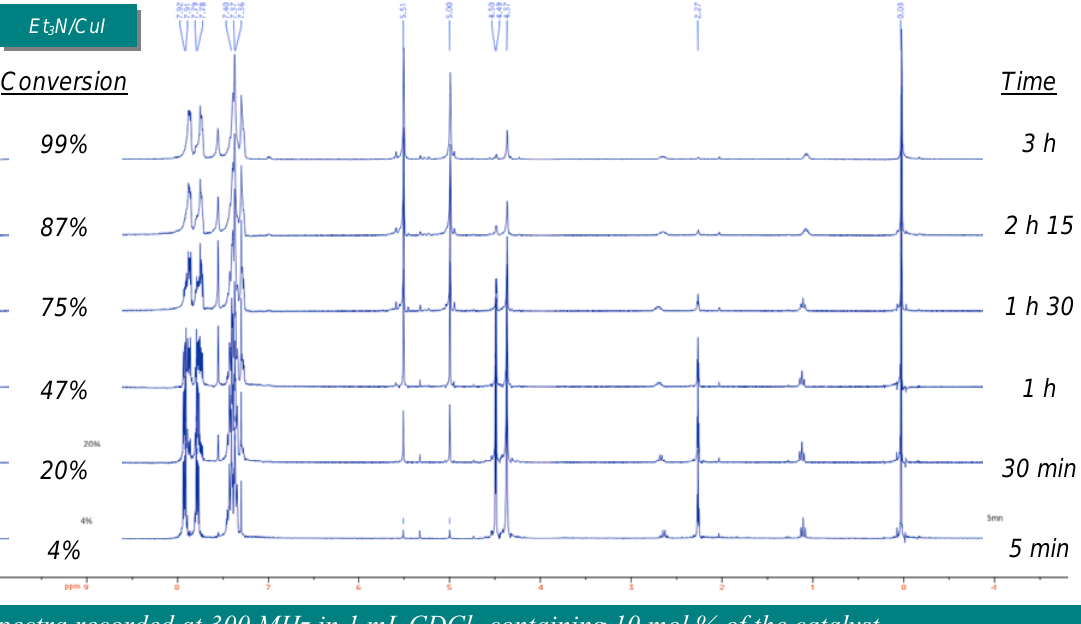
containing 10 mol % of the catalyst 3 ) for the formation of 3 . 3